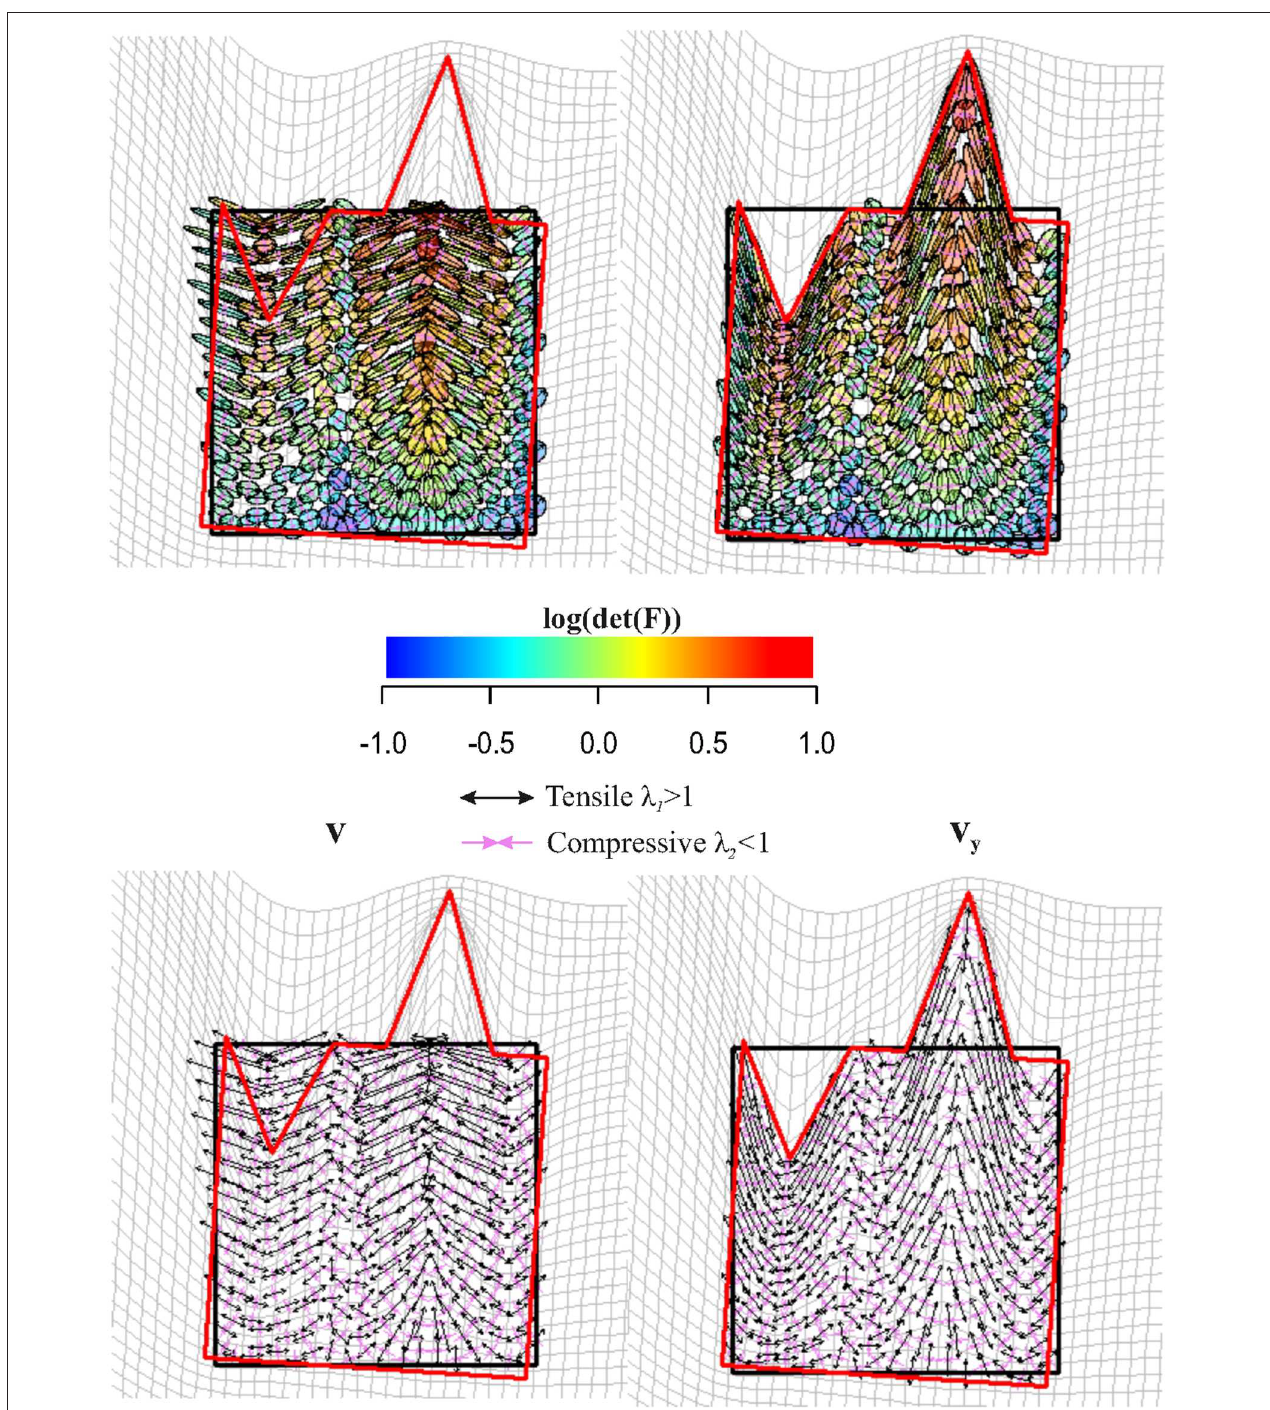
FIGURE 10 | Top row : C (left) is used to deform unitary spheres appropriately rescaled for sake of visualization; F (right) was used for the same purpose on the target configuration. Ellipse’s color is proportional to log(det( F )). Values < 0 indicate a reduction in local area, values > 0 indicate an expansion. Bottom row : the direction of deformation is dictated by v y and v y (i.e., SD ellipse’s axes). Tensile and compressive SD actions are indicated. Source and target shapes were aligned via OPA. ˆ = species (Barnosky, 1981, 1982; Piras et al., 2015). For our the clade to which Mesoscalops belongs, shows one of the most peculiar humeral morphologies among mammals, with experiment here, we used CT scan data from Piras et al. (2015) unique shape and mechanical stress in the context of burrowing for M. montanensis and for the non-complex tunnel digger